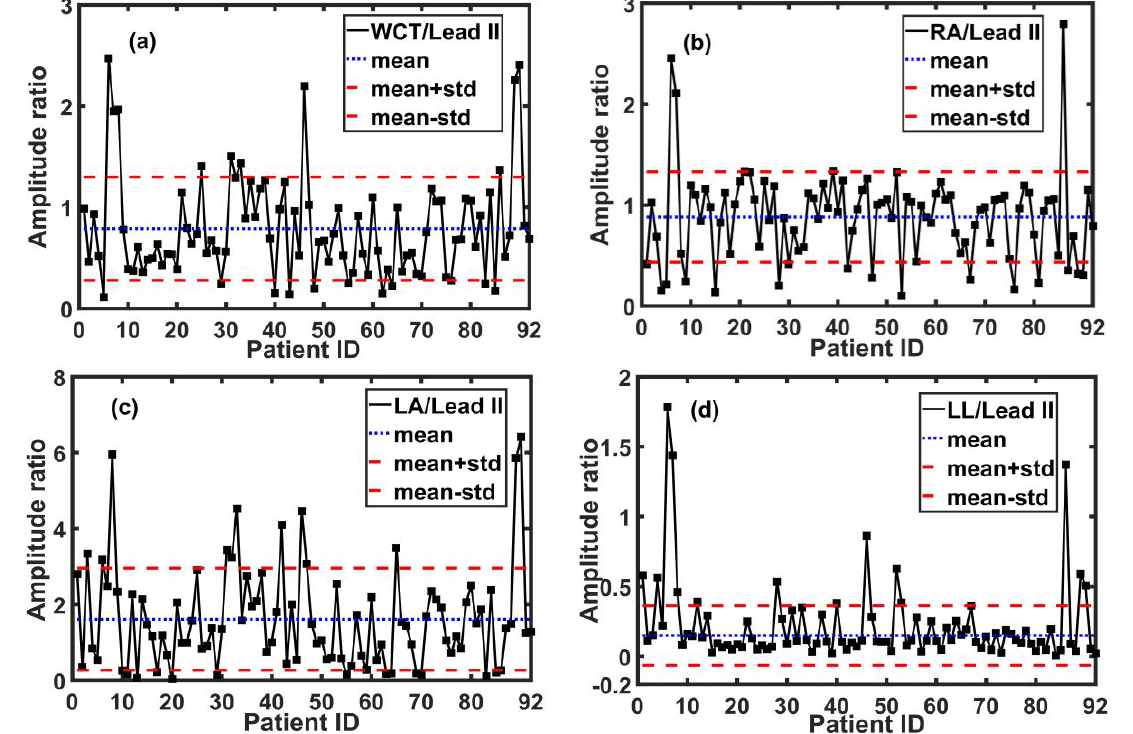
Figure 7. The amplitude of the WCT, LA, RA, and LL with respect to lead II for all 92 patients. Panel ( a ): the WCT / lead II is in the range of [0.11, 2.47] with an average of 0.78; Panel ( b ): the RA / lead II is in the range of [0.01, 2.7] with an average of 0.88; Panel ( c ): the LA / lead II is in the range of [0.038, 6.41] with an average of 1.61; and Panel ( d ): the LL / lead II is in the range of [0.007, 1.78] with an average of